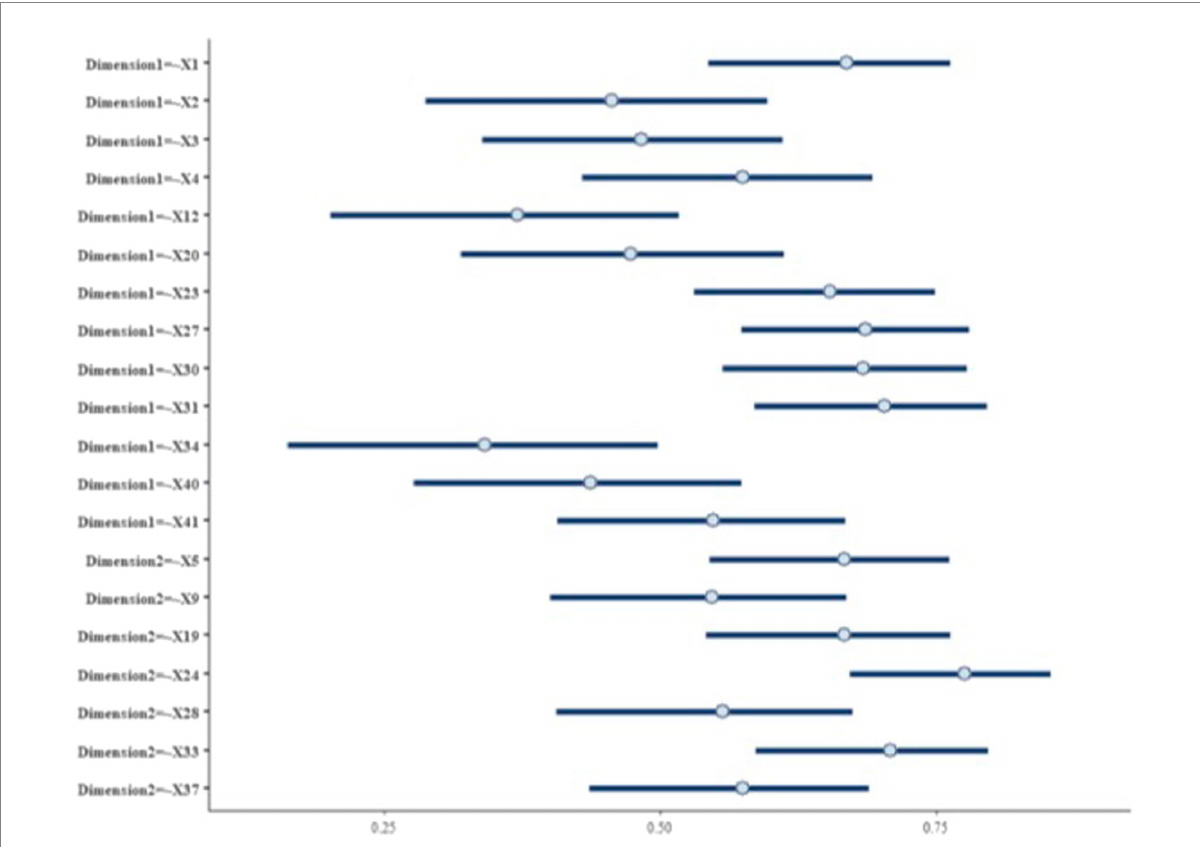
FIGURE 4 BCFA 95% HDI posterior estimate on the standardized factor loading. The latent dimensions identified on each item have been also reported on the